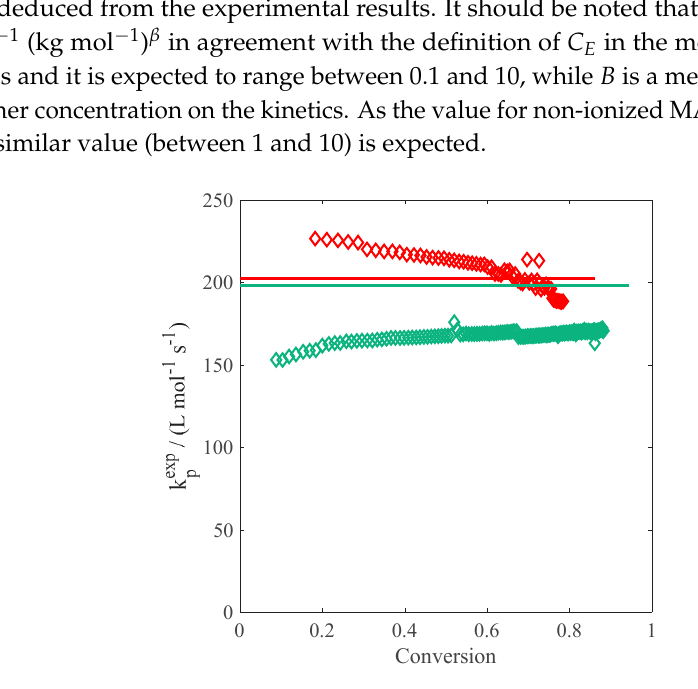
Figure 7. Propagation rate coefficient as a function of the monomer conversion calculated from the termination rate coefficient in Table 5 and the experimental data of conversion versus time of fully ionized MAA polymerization at constant ionic strength equivalent to 5 wt % MAA by addition of NaCl. Variation of monomer concentration 1 wt % (red) and 5 wt % (green, no NaCl addition): comparison with the simulated k p using the model equations